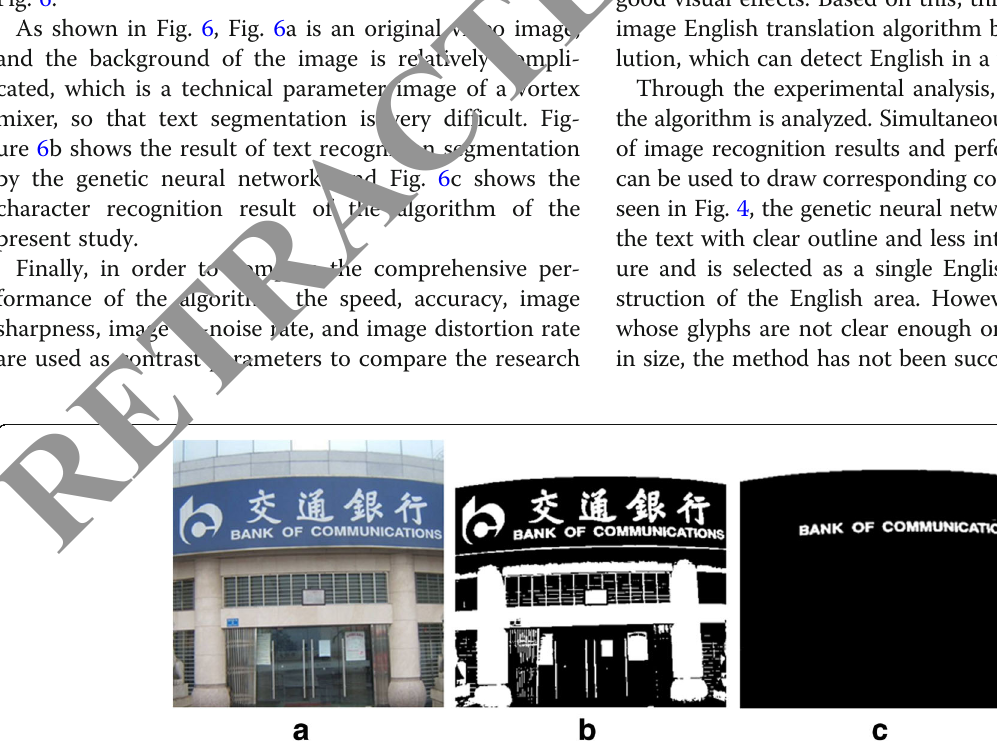
Fig. 5 English recognition of pictures with complex